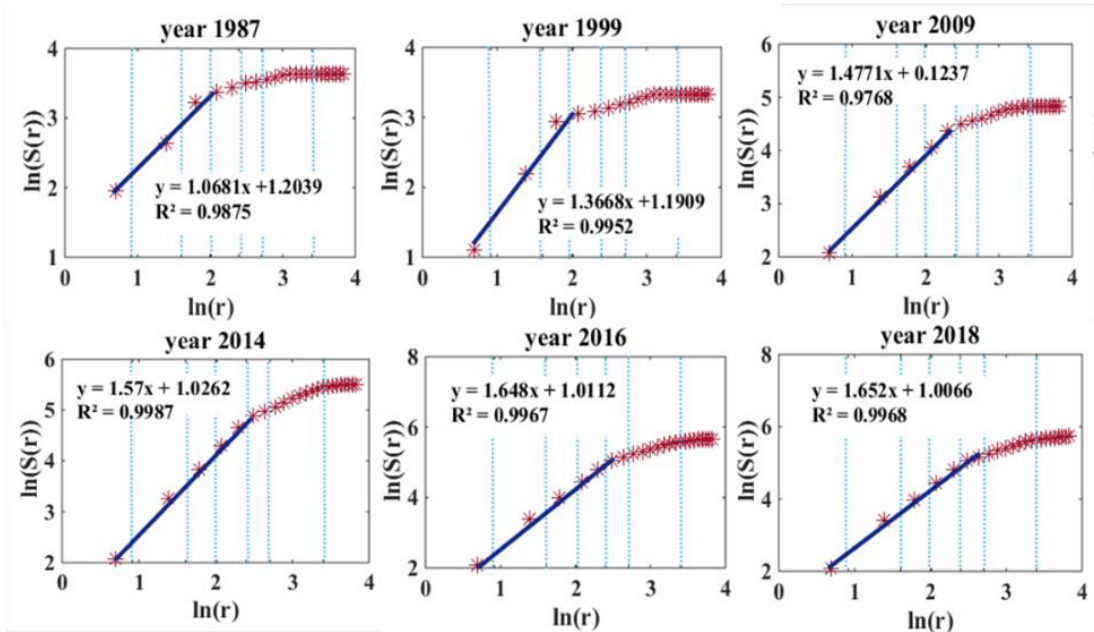
D . All volume dimensions for each V